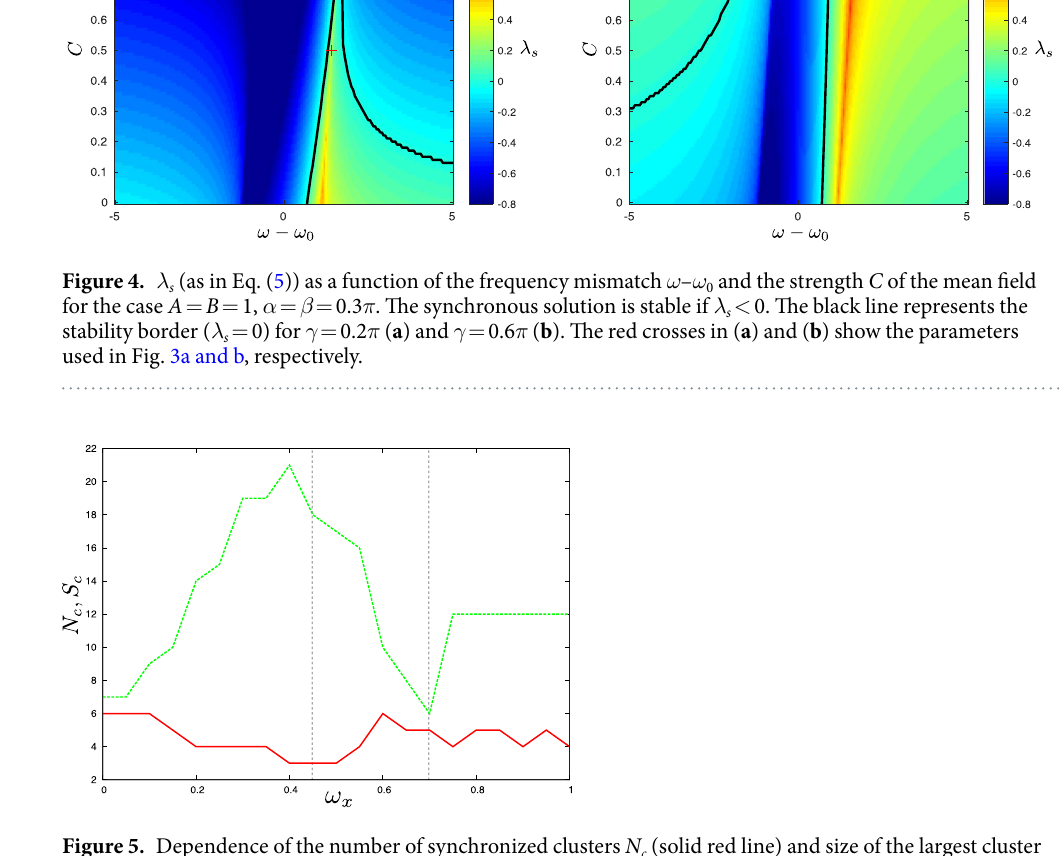
Figure 5. Dependence of the number of synchronized clusters N c (solid red line) and size of the largest cluster S c (dashed green line) on the hub frequency multiplier ω x . The parameters are ε = 5, δ = 0.2 π . For increasing values of the frequency multiplier, the size of the largest synchronized component presents a bell-shaped behavior, with the largest synchronized cluster observed for ω x =